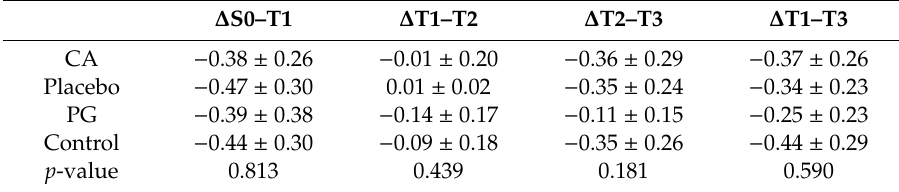
Table A2. Mean radiographical interval changes of marginal bone level